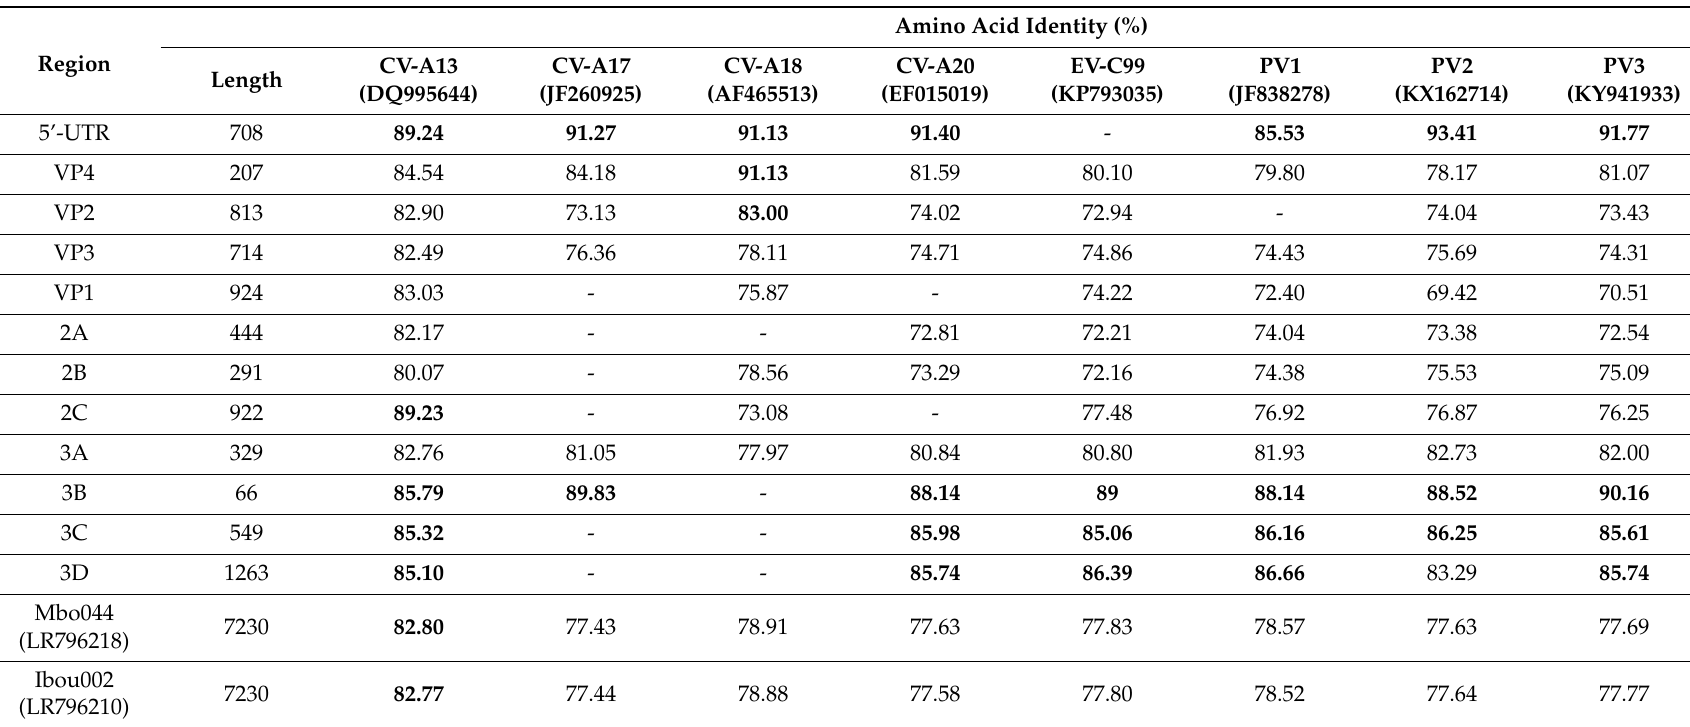
Table 1. Identity between the genomes of Ibou044 and Mbo02 strains with non-polio enterovirus C and polioviruses. Highest identity is in bold.